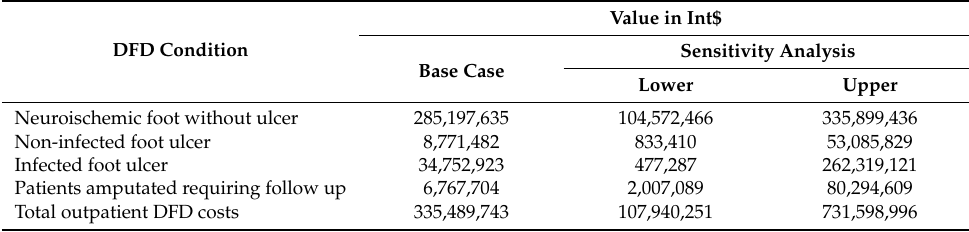
Table 4. Estimated annual direct medical costs of diabetic foot disease (DFD) outpatients. Base-case and sensitivity analysis. Brazil,